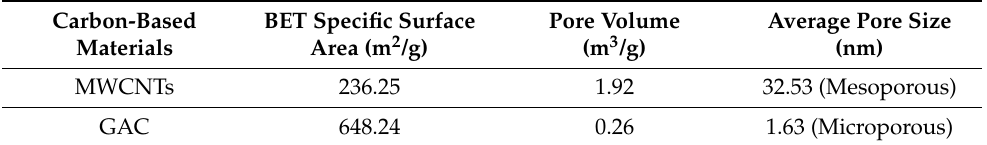
Figure 3. Reduction % of Cr(VI), Fe(III) and UV absorbance appearance at 730 nm with reduction of PMo 12 O 403 − by MWCNT and GAC at acidic pH condition, respectively, ( a ) at 5 min and ( b ) at 60 min ([Fe(III)] o = 0.2 mM, [Cr(VI)] o = 0.1 mM, [PMo 12 O 403 − ] o = 1.0 mM, [CNT] o = [GAC] o = 2.0 g/L, pH o = 3, anaerobic condition, [reaction time = 6 and 60 min]). Table 1. Detailed characteristics of MWCNTs and GAC.